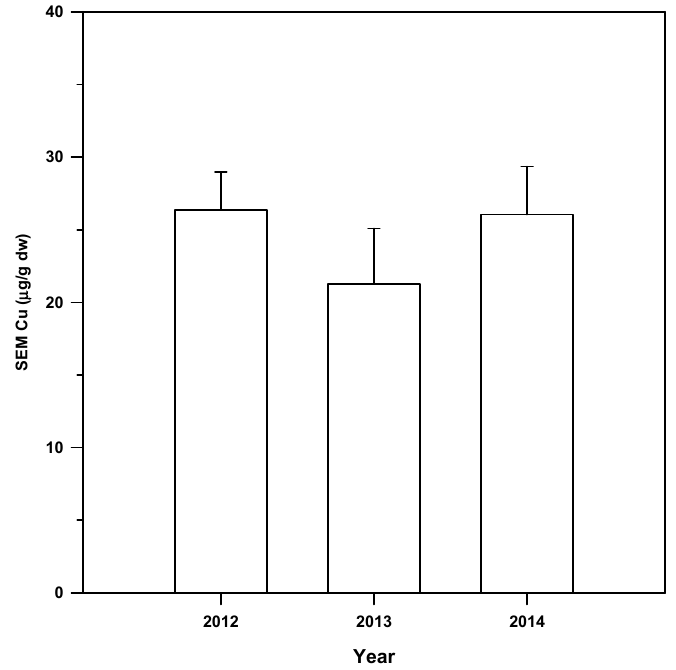
Figure 23. All Spring Cache Slough SEM Cu sediment data by year (ANOVA, p = 0.062).